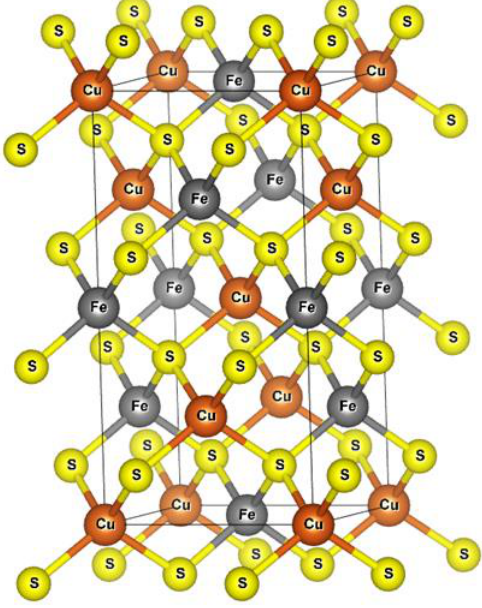
Figure 1. Unit cell model of chalcopyrite.